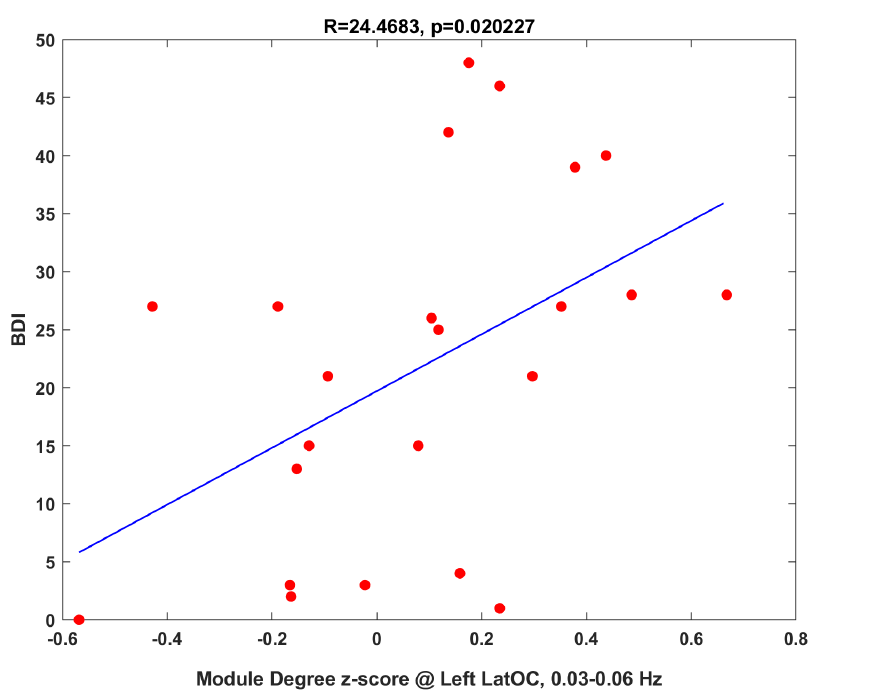
Figure 5. Network measure, module degree z-score of left lateral occipital cortex in the 0.03–0.06 Hz band, correlates with clinical BDI score for both baseline and after treatment with coefficient R = 24.4683 and its p -value = 0.020227. Note that the dependence between baseline and post- treatment measurements could cause the inflation of false positive rate. One subject who could not finish the after-treatment clinical assessment is excluded from the